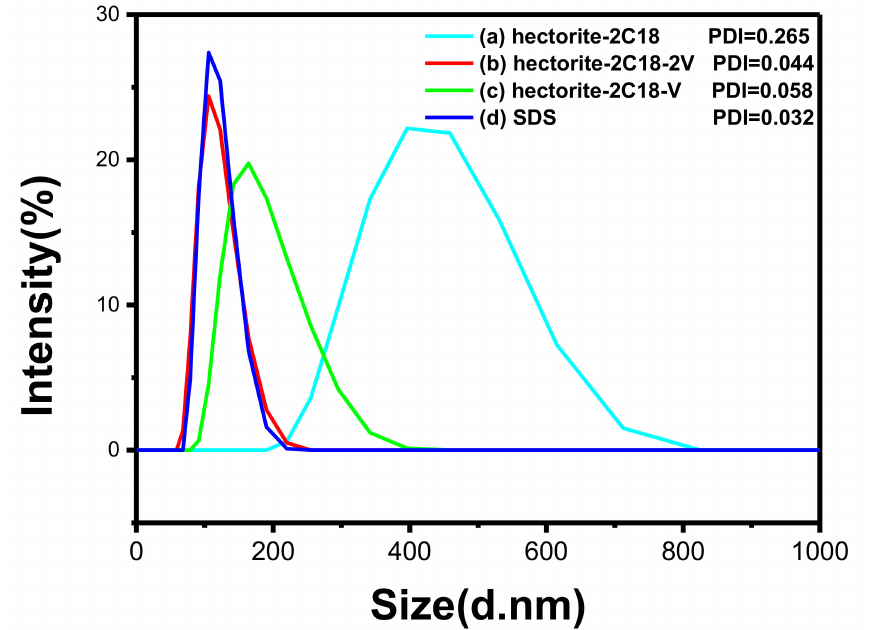
Figure 6. DLS results of polyacrylate latex stabilized by different stabilizers: ( a ) stabilized by hectorite-2C18, ( b ) stabilized by hectorite-2C18-2V, ( c ) stabilized by hectorite-2C18-V,( d ) stabilized by conventional surfactant SDS. The dispersion was diluted to approximately 1wt% with distilled